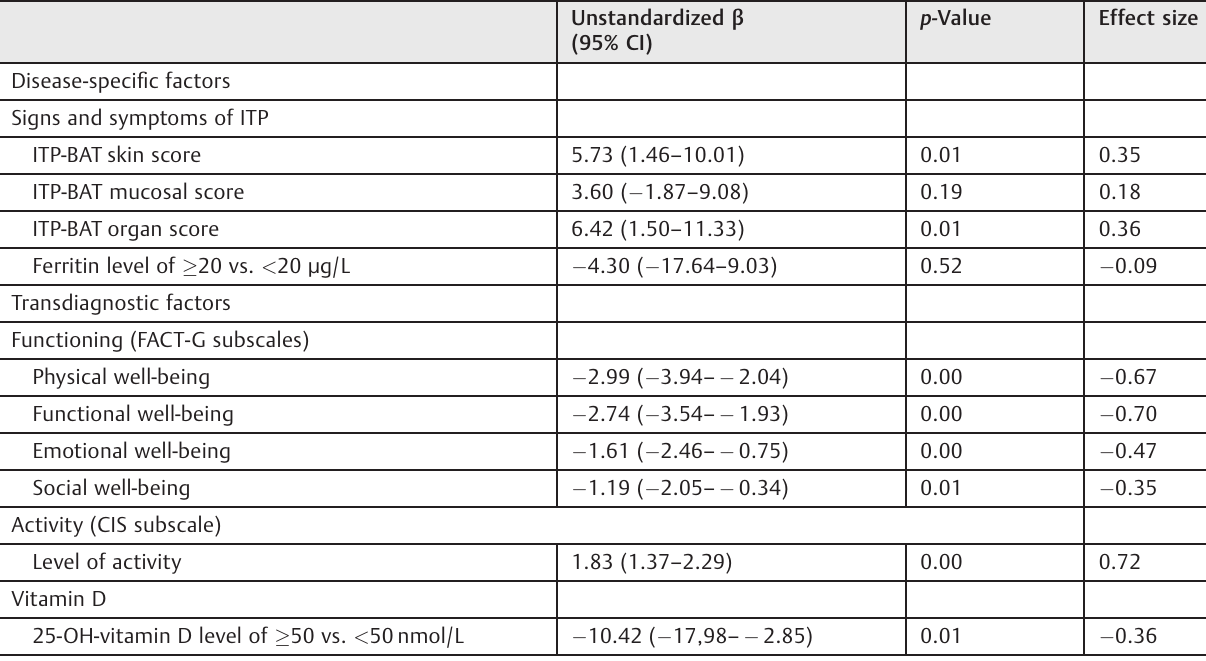
Table 3 Univariable linear analyses (corrected for confounders) for each of potentially modi fi able factors with fatigue as dependent variable